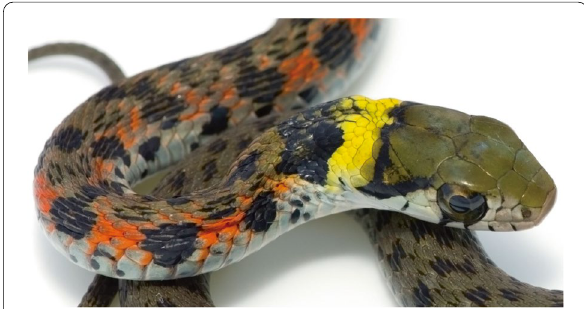
Fig. 1 Rhabdophis tigrinus . A common colubrid snake found in eastern Asia. The average total length is usually 50–150 cm